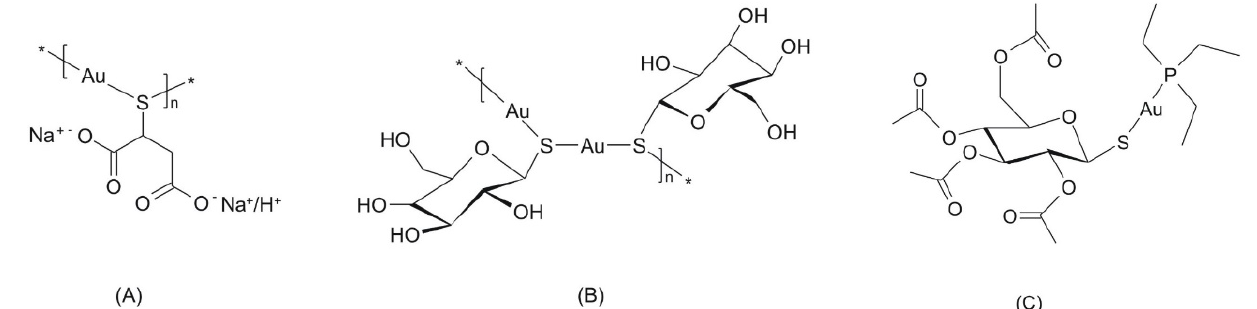
Figure 1. The structural formulas of three major gold-containing pharmacotherapeutics: natrium- aurothiomalate ( A ), aurothioglucose ( B ) and Auranofin ( C ). The asterisk symbols (*) mark the sites where the head-to-tail coupling of the monomeric units to the polymeric chain occurs.